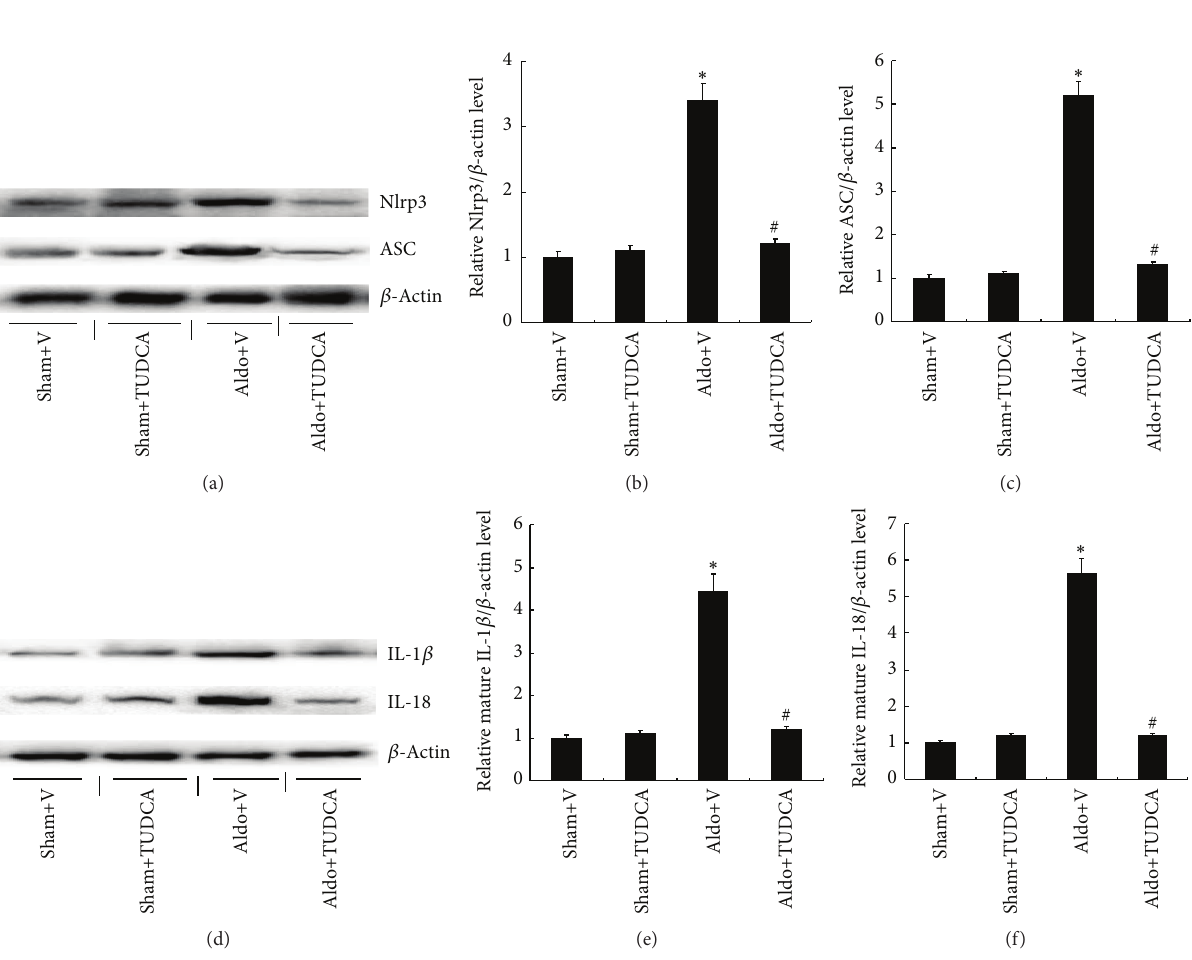
Figure 6: TUDCA attenuated Nlrp3 inflammasome activation in Aldo-infused mice. (a) Representative Western blots of Nlrp3 and ASC. (b) Relative expression of Nlrp3 to the expression of 𝛽 -actin. (c) Relative expression of ASC to the expression of 𝛽 -actin. (d) Representative Western blots of IL-1 𝛽 and IL-18. (e) Relative expression of IL-1 𝛽 to expression of 𝛽 -actin. (f) Relative expression of IL-18 to the expression of 𝛽 -actin. Values are mean ± SEM ( 𝑛 = 6 ). ∗ 𝑝 < 0.05 , Sham+V group versus Aldo+V group, # 𝑝 < 0.05 , Aldo+V group versus Aldo+TUDCA